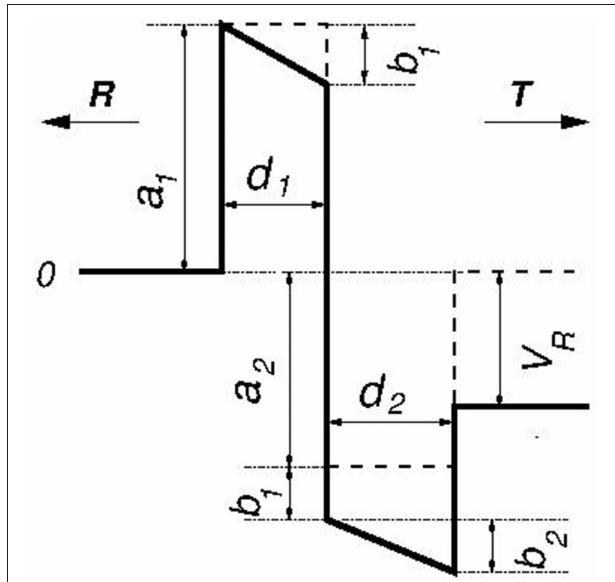
FIGURE 3 | Schematics of tilted (solid line) and piecewise constant (dashed line) barrier-well potential, where notations correspond to Equations (73) and (74) for N 2 and ε 1. Potential values at layer edges are V 1,0 = = V 1,1 a 1 b 1 (barrier, a 1 > 0) and V 2,1 = + (well, a 2 < 0). Polarity is shown positive (left-to-right electron flow, b 1 , b 2 < 0). Dashed lines show unbiased potential ( b 1